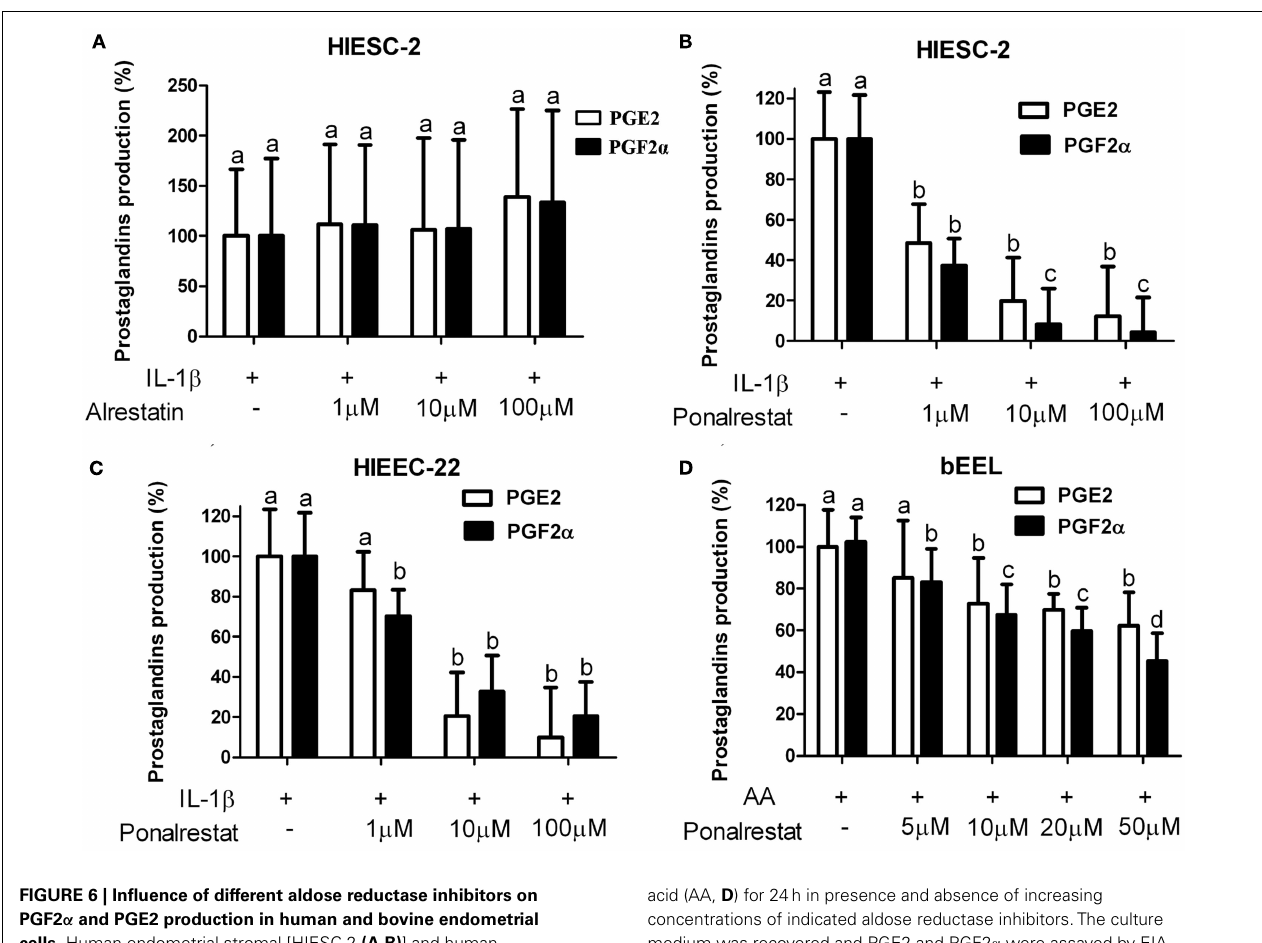
FIGURE 6 | Influence of different aldose reductase inhibitors on PGF2 α and PGE2 production in human and bovine endometrial cells. Human endometrial stromal [HIESC-2 (A,B) ] and human [HIEEC-22 (C) ] or bovine epithelial [bEEL (D) ] cells were grown to confluence and treated with 1ng/ml IL-1 β (A–C) or 10 μ M arachidonic